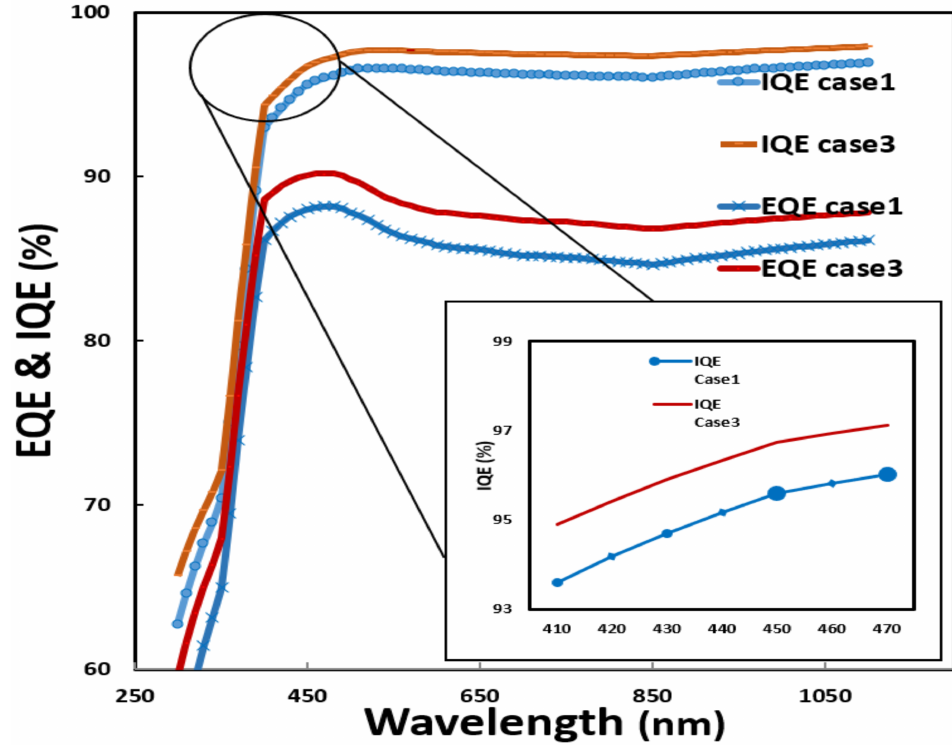
Figure 2. EQE and IQE vs. optical wavelength for case 1 and case 3.